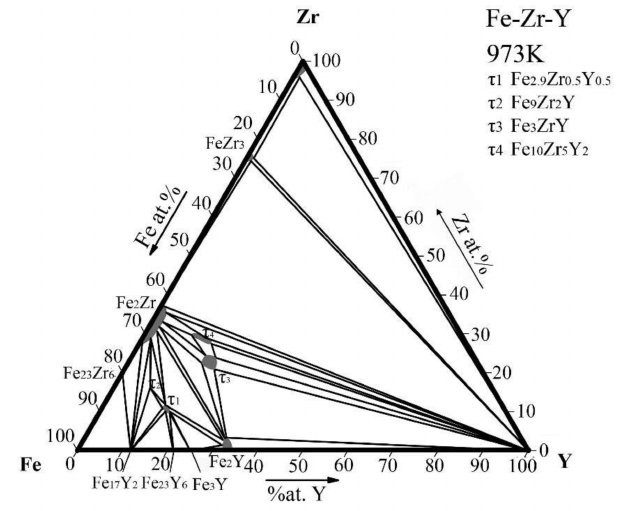
Figure 5. Isothermal section of the Fe-Zr-Y ternary system at 973 K determined in this work.